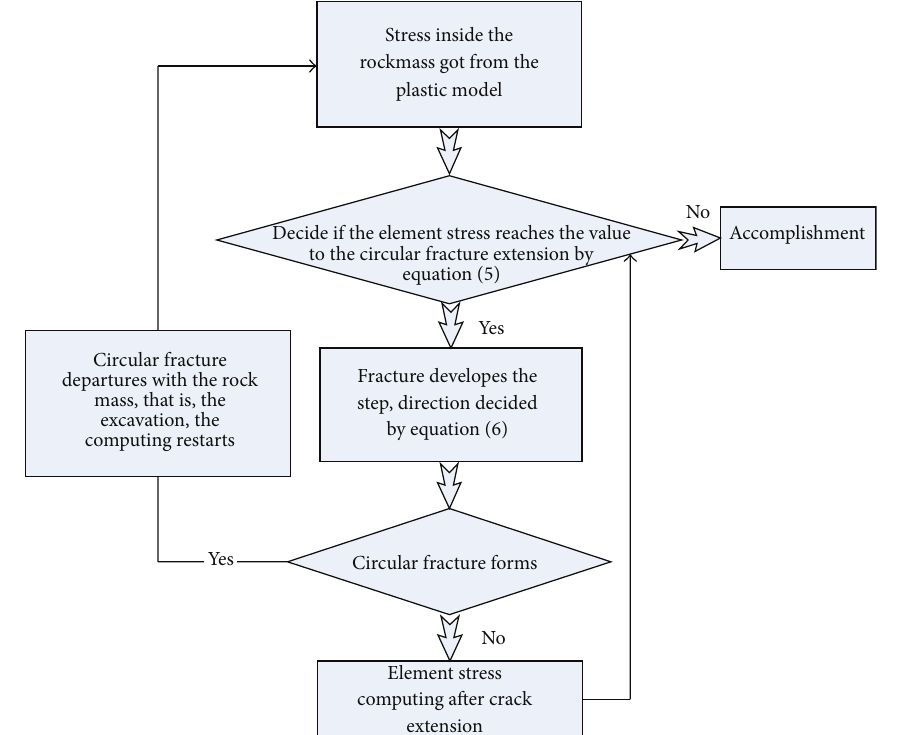
Figure 9: Block diagram of the simulating procedure of zonal disintegration.